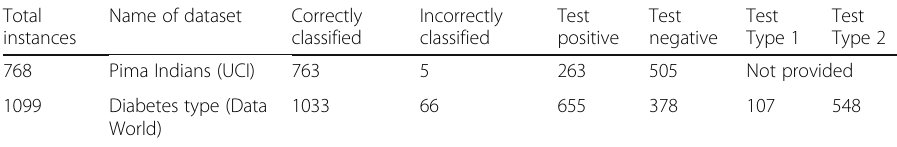
Table 8 Performance of the proposed model on the basis of the classified instances Total